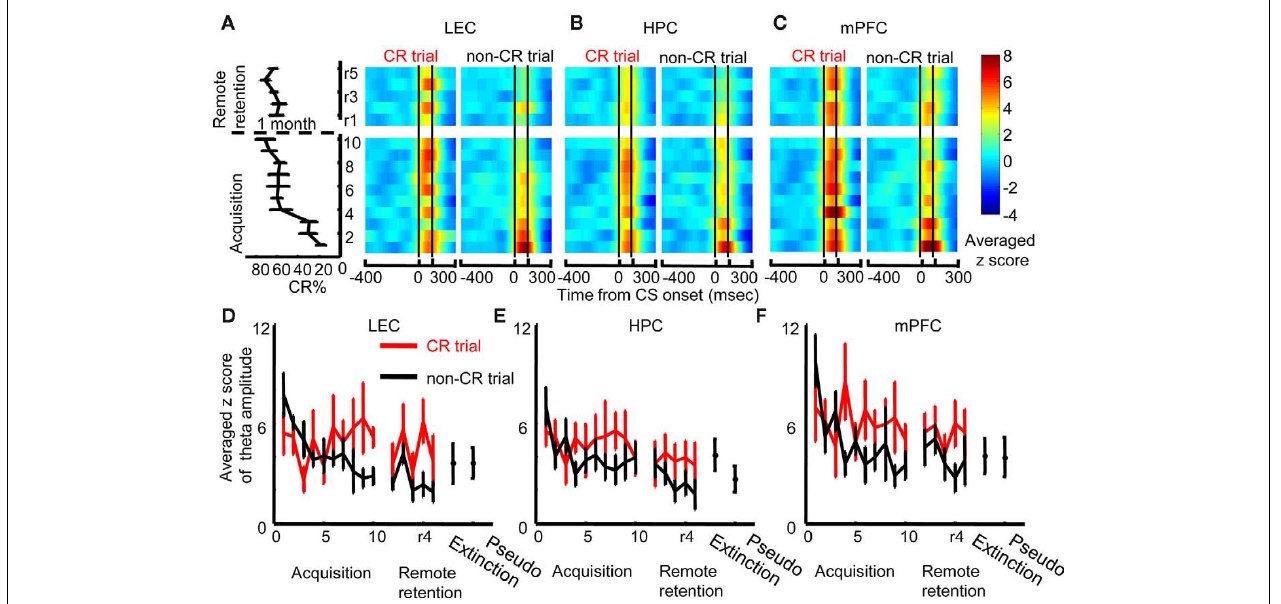
(HPC) decreased with learning and did not differ between CR trials (left) and non-CR trials (right). (C) In the medial prefrontal cortex (mPFC), CS-evoked increase in theta amplitude was high in CR trials as well as non-CR trials. Subsequently, theta amplitude stayed high in CR trials and decreased in non-CR trials. (D–F) Time-dependent changes in theta amplitude were confirmed by plots representing the averaged maximum z -score values for theta amplitude during acquisition (mean ± SEM from six rats) and remote retention (mean ± SEM from eight rats). Red and black lines indicate theta amplitude in CR and non-CR trials, respectively. CS-evoked increase in theta amplitude in the LEC and mPFC, but not HPC, was relatively weak during extinction and pseudo-conditioning, during which the stimulus contingency was